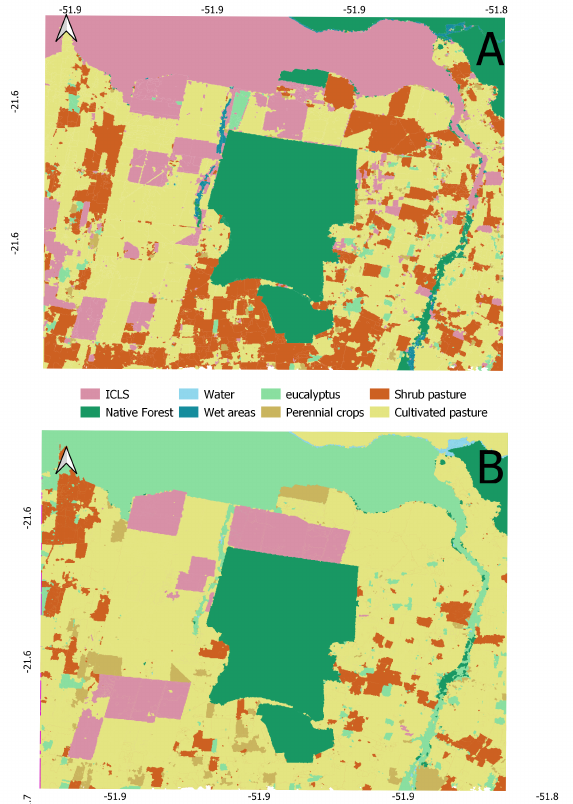
Figure 4. Predictions for the best result for each algorithm (A - LSTM (Entire season), B - random forest (180